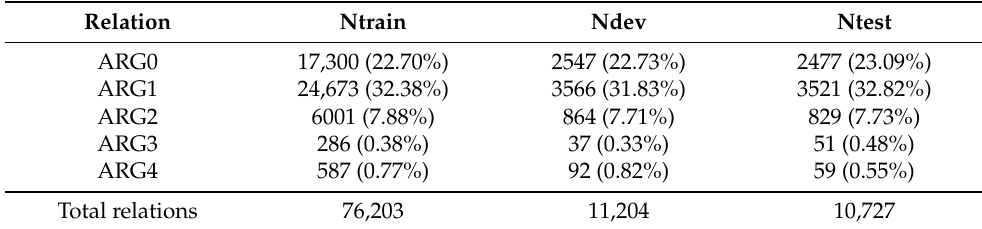
Table 1. Statistics of core roles from AMR graph in CommonsenseQA .